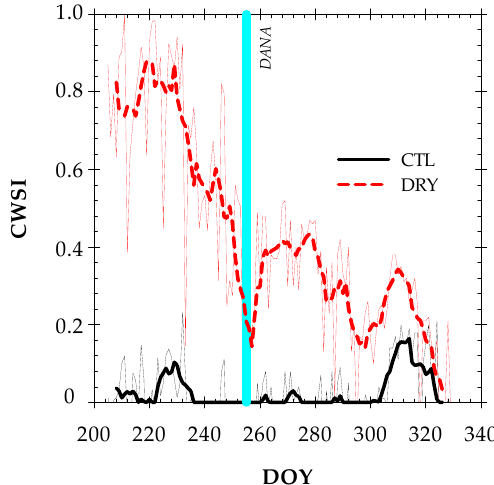
Figure (cid:561) 6. (cid:561) The (cid:561) time (cid:561) course (cid:561) of (cid:561) the (cid:561) Crop (cid:561) Water (cid:561) Stress (cid:561) Index (cid:561) (CWSI) (cid:561) for (cid:561) CTL (cid:561) (full (cid:442) irrigated) (cid:561) and (cid:561) DRY (cid:561) Figure 6. The time course of the Crop Water Stress Index (CWSI) for CTL (full-irrigated) and DRY (non (cid:442) irrigated) (cid:561) treatments (cid:561) during (cid:561) the (cid:561) experiment. (cid:561) The (cid:561) bold (cid:561) lines (cid:561) show (cid:561) the (cid:561) seven (cid:442) day (cid:561) moving (cid:561) av (cid:556) (non-irrigated) treatments during the experiment. The bold lines show the seven-day moving erages. (cid:561) The (cid:561) solid (cid:561) vertical (cid:561) cyan (cid:561) line (cid:561) indicates (cid:561) the (cid:561) DANA (cid:561) event. (cid:561) averages. The solid vertical cyan line indicates the DANA event.